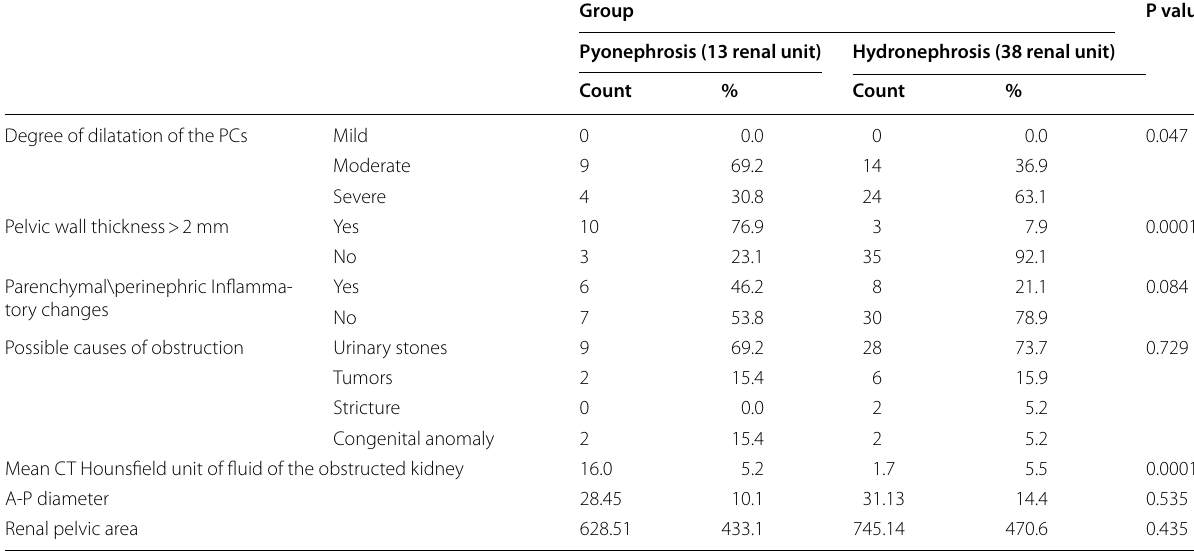
Table 4 CT findings among the study groups